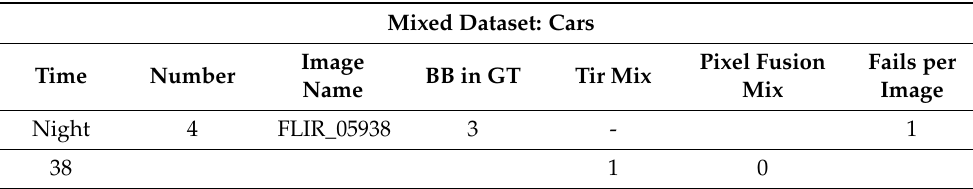
Table A7. Networks trained with mixed datasets failed to classify a single image for car objects,